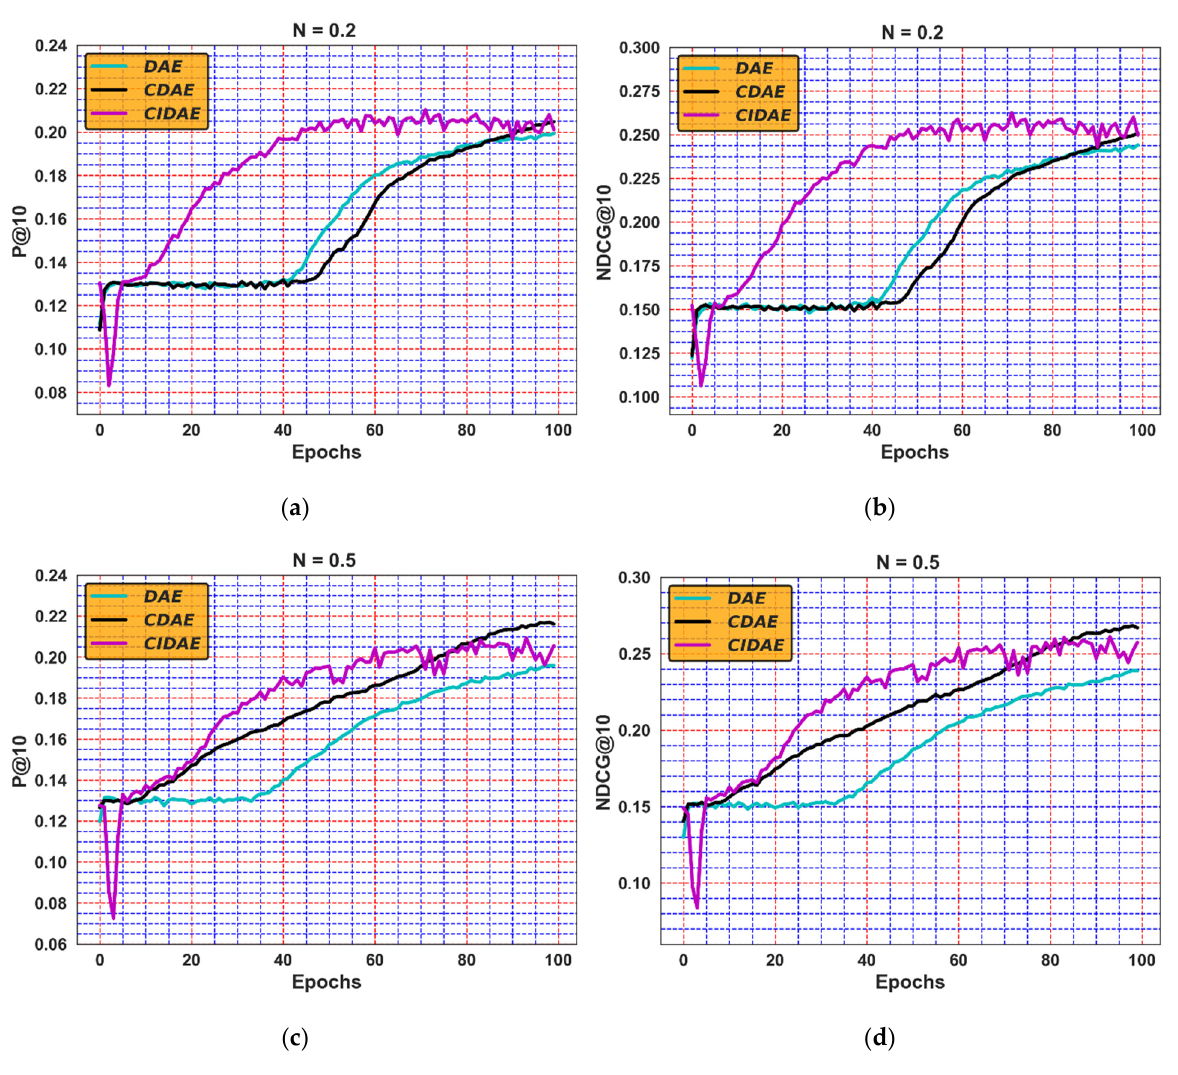
Figure 12. Performance comparison of ML ‐ 1M through P@10 and NDCG@10 metrics.